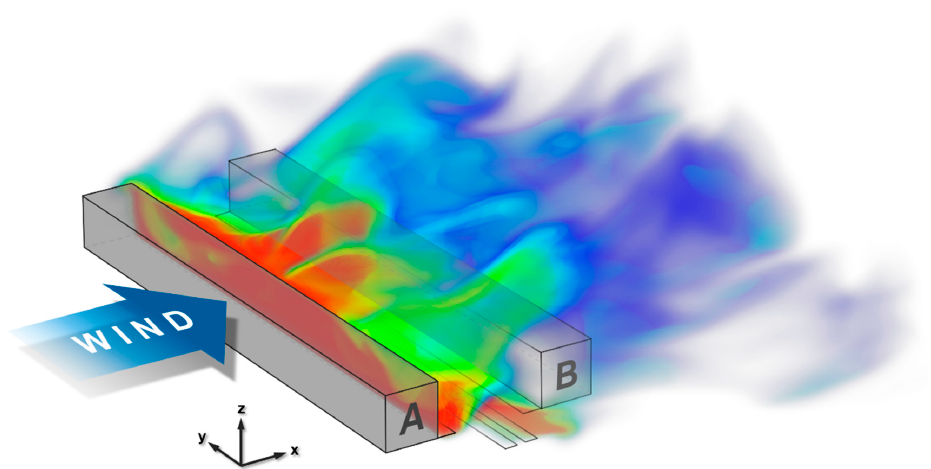
Figure 1. Instantaneous air pollutant concentration field in the vicinity of an isolated street canyon with a height-to-width ratio of 0.5, computed by ANSYS Discovery Live. Warmer colors indicate higher concentrations of air pollutants.